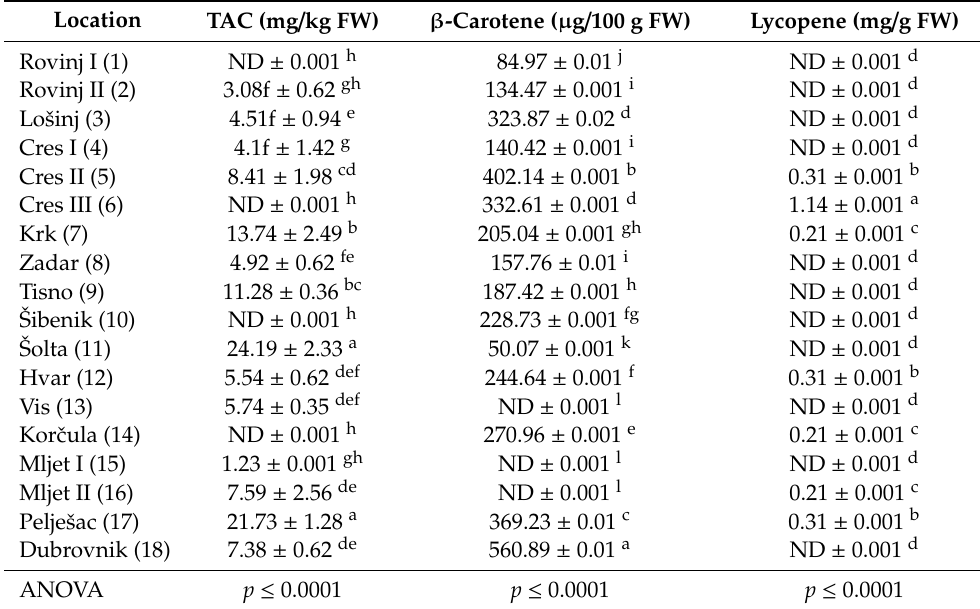
Table 3. Pigment compounds content of strawberry tree fruit from di ff erent